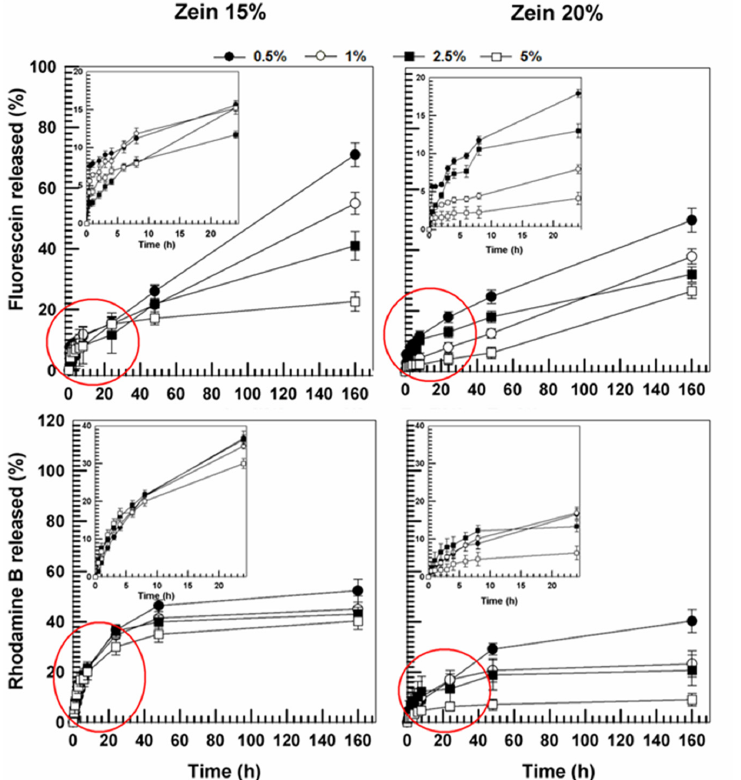
Figure 12. Release profile of disodium fluorescein and rhodamine B from zein gels (15%, 20% w/v ) as a function of the amount of entrapped drug and time. Values represent the mean of three different experiments ± standard deviation. Molecules 2020 , 25 , x FOR PEER REVIEW